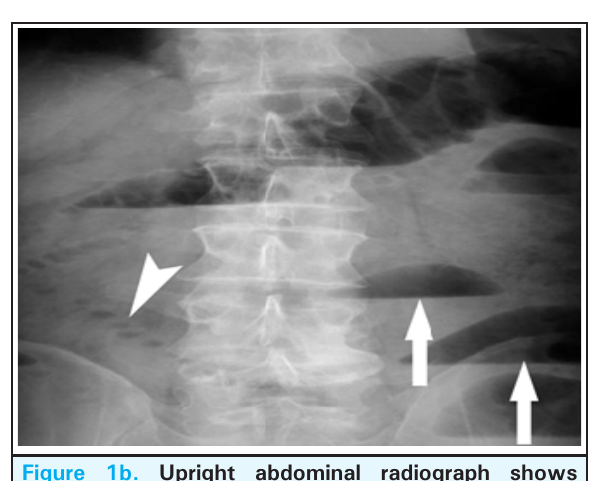
Figure 1b. Upright abdominal radiograph shows multiple air - fluid levels (arrows) and string-of-pearls sign (arrowhead).